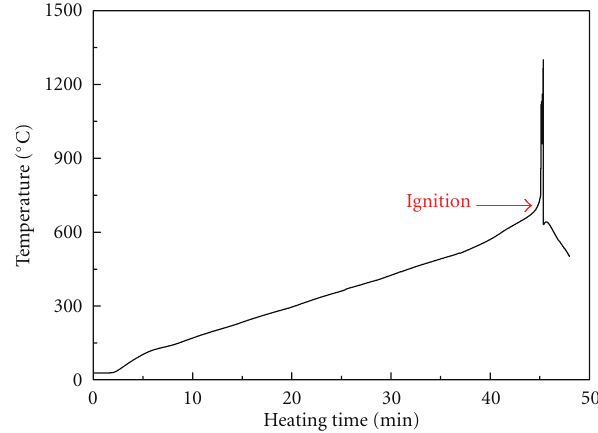
Figure 2: Temperature-time curve during heating of TiC-TiB 2 - Ni(60/20/20)